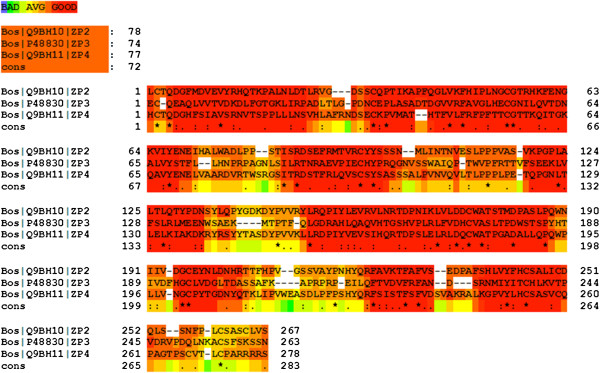
Sequence alignment of bovine Zona pellucida sperm-binding protein ZP domains. Top lane: Bovine ZP2 (UniProtKB: Q9BH10) ZP domain sequence. Second lane: Bovine ZP3 (UniProtKB: P48830) ZP domain sequence. Third lane: Bovine ZP4 (UniProtKB: Q9BH11) ZP domain sequence. Fourth lane: consistency. Asterisk (*) denotes identical residue; colon (:), conservative change; period (.), related substitution. Dark red indicates residues aligned in a similar fashion among all the individual MSAs (multiple sequence alignments). Dark yellow, orange and red residues can be considered to be reliably aligned. The top of the output provides the average consistency (ranging from of 0 to 100) for each sequence, indicating sequence alignment reliability (score lower than 50 is considered poor). Hereafter, amino acids are represented by single letter code for amino acid residues. The alignment was performed using the M-Coffee program [29].